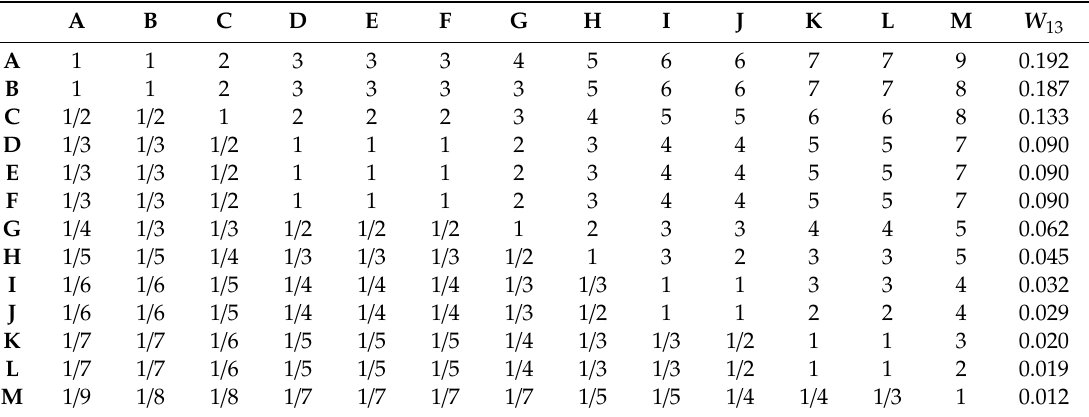
Table 4. A Pairwise comparison